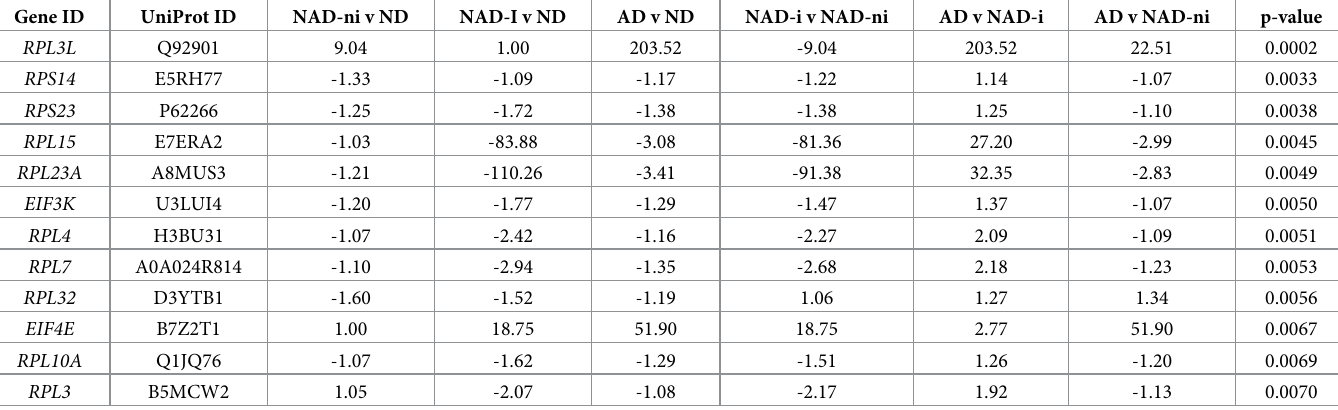
Fold changes are given for all individual comparisons. P-values are given for 4-way ANOVA analysis while all available 2-way p-values can be found in S2 Table. Proteins were determined using IPA (Qiagen, Germantown, MD).